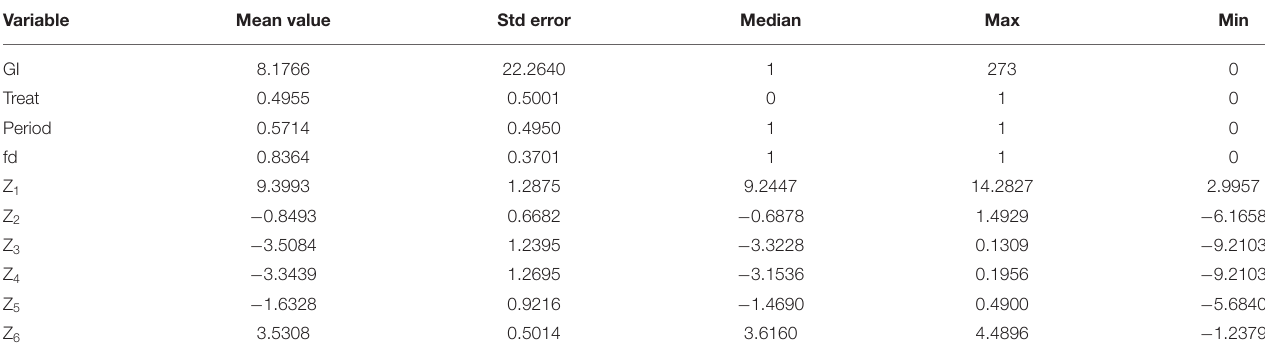
TABLE 2 | Descriptive analysis of major